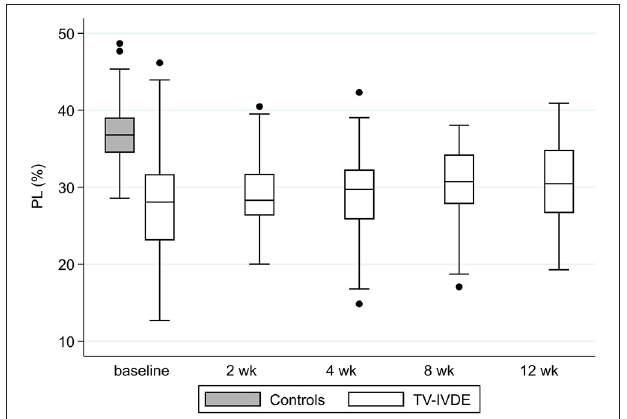
FIGURE 2 | Absolute LRA for each study visit in dogs with TL-IVDE compared to healthy control dogs. aLRA: absolute left right asymmetry between left and right pelvic